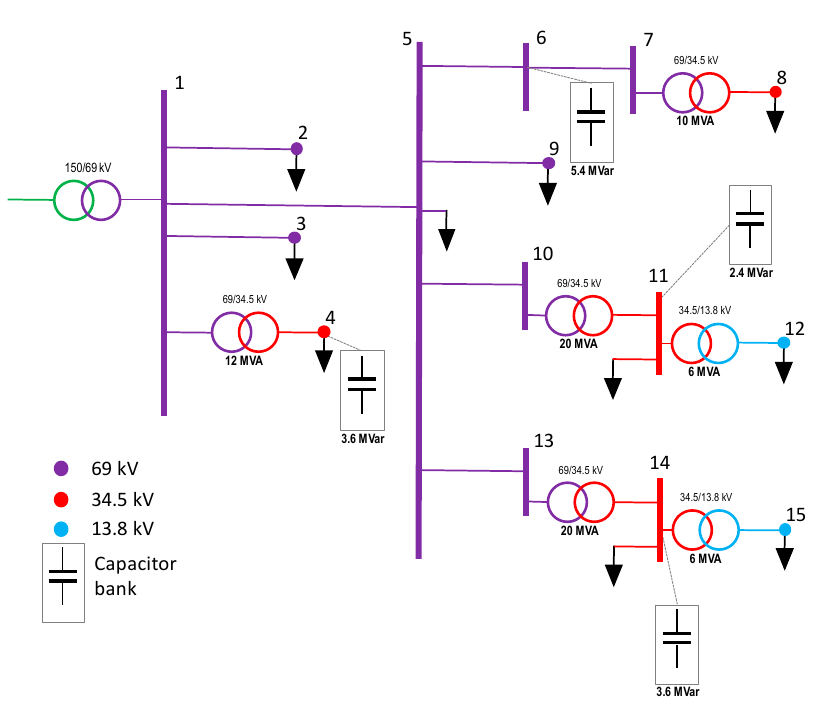
figuration described in Figure 9 returns a high level of power factor violation ( 𝑉𝑖𝑜𝑙% (cid:2869)(cid:3043)(cid:3033) = 64.1% ) and a high total OF value (9.74 M$/year). For these reasons, in case b, it is funda- mental to control the daily schedule to limit the overcompensation cases; in particular, this control switches off the units in nodes 4 and 14 in the last representative day (Q4, weekend) to reduce the power factor violation at 𝑉𝑖𝑜𝑙% (cid:2869)(cid:3043)(cid:3033) = 21.3% . The good level of power factor, despite the switching operation for some capacitor units, allows a further reduction in minimizing the losses (7.3% vs. 7.6%, case a).